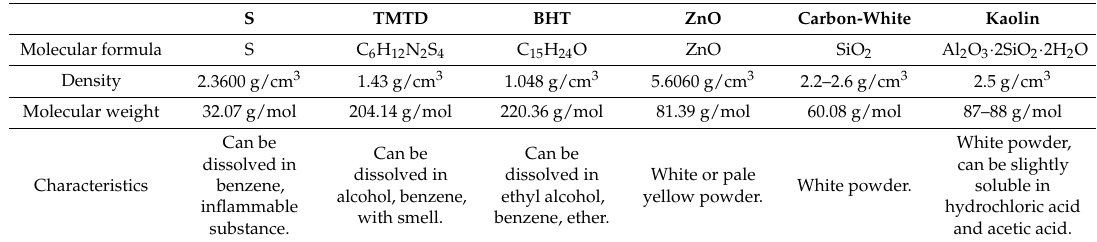
Table 3. Technical indicators of S, TMTD, BHT, ZnO, carbon-white and kaolin.